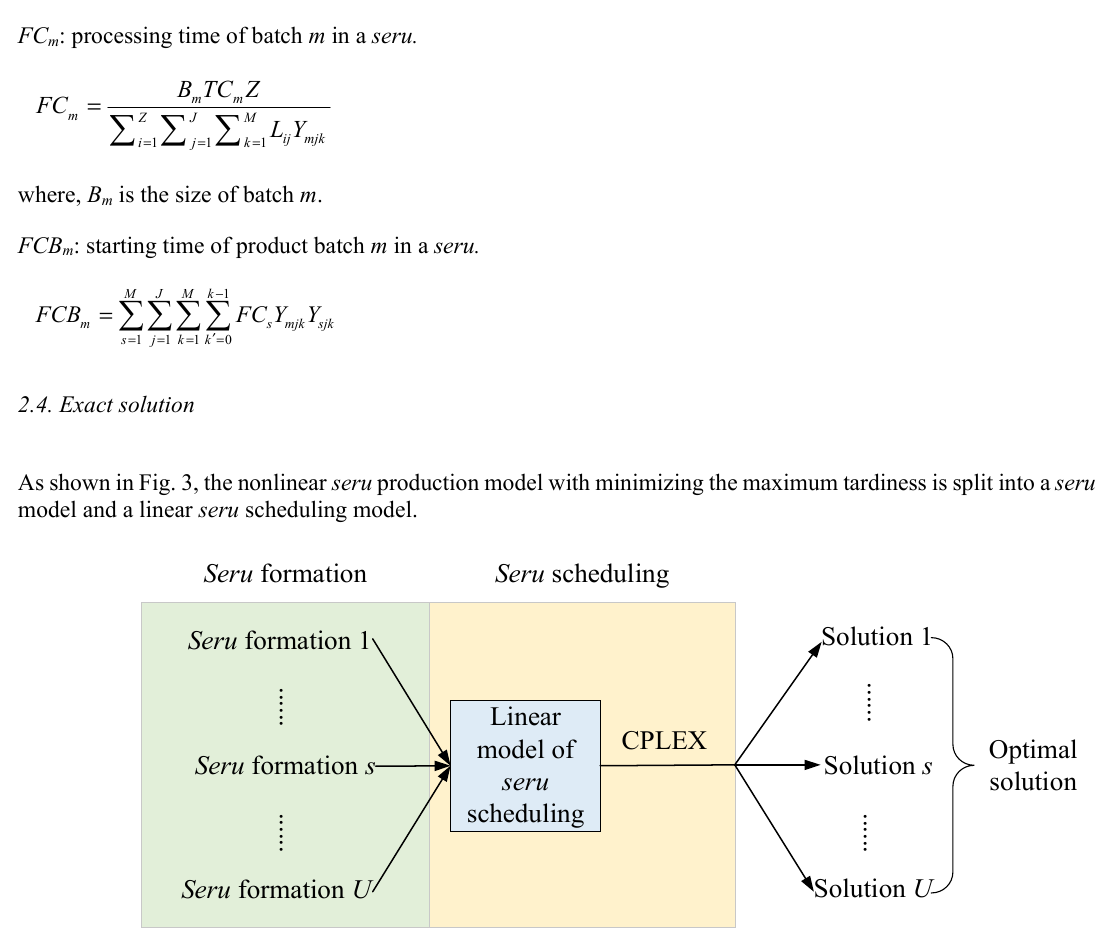
Fig. 3. The process of solving the exact